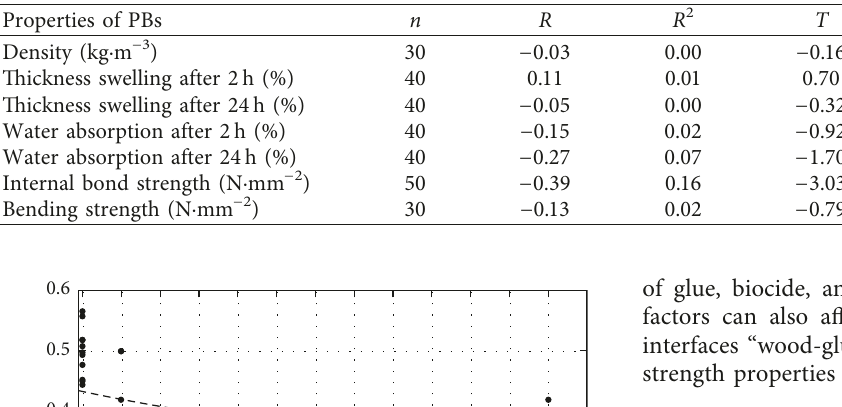
Table 4: Linear correlation analyses between the proportion of nano-ZnO in MUF glues ( x PBs containing nano-ZnO ( y ).